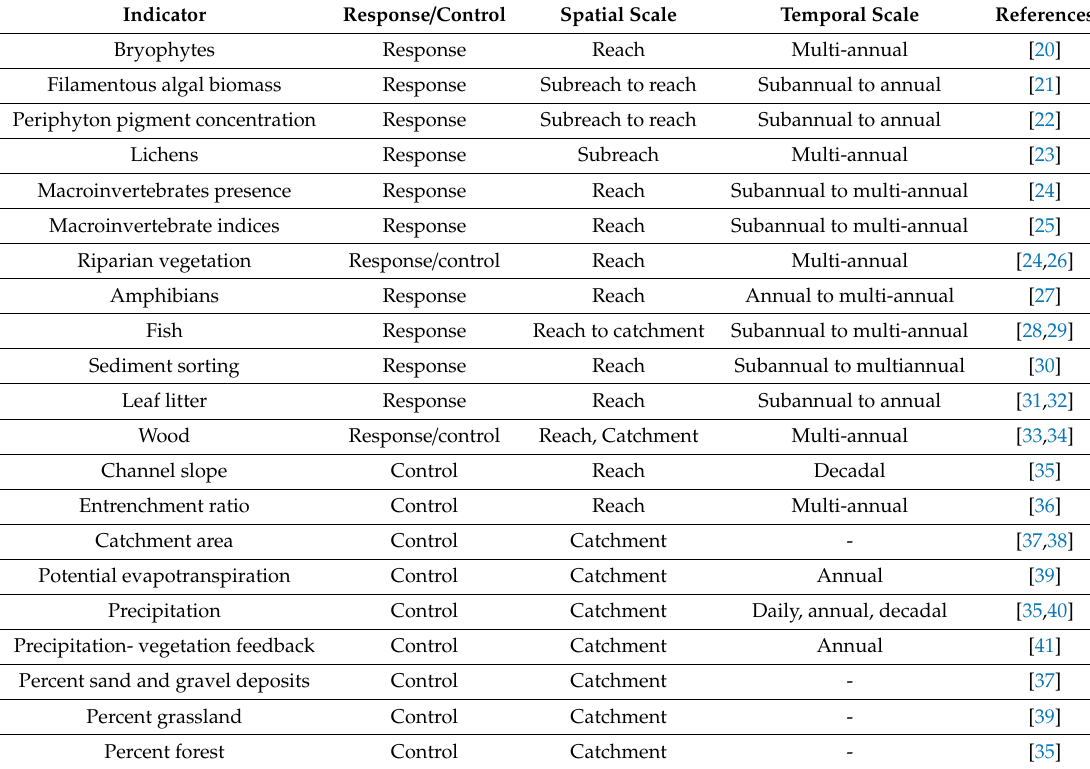
Table 1. Examples of response and control indicators of streamflow duration evaluated over spatial and temporal scales. - is not